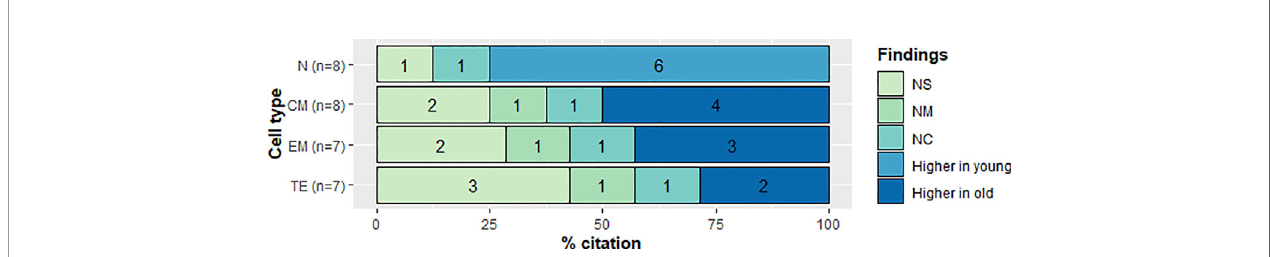
FIGURE 6 | Qualitative analysis of frequency in CD4+ T cell subsets. CD4+ T cell subset and citation percent across studies comparing young and old populations. N, naive; CM, Central Memory; EM, Effector Memory; TE, Terminally Effector; NS, No Signi fi cant change; NM, Non measured; NC, not